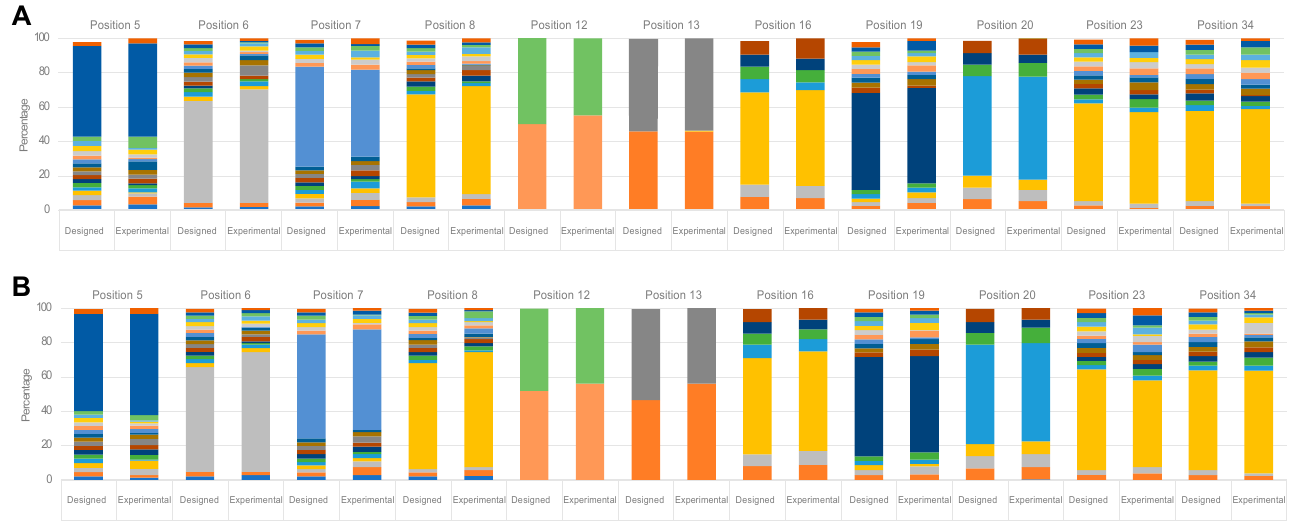
Figure 2. Library distribution in percentage for Sq lib in the ( A ) first subunit and ( B ) second subunit at randomized positions. Generally, the design is maintained in the created library pool.